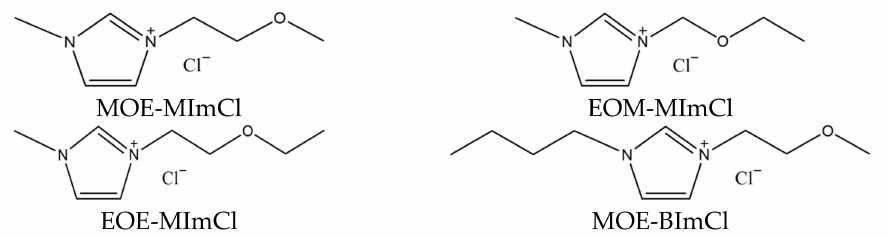
Figure 1. Structures of ether-functionalized ionic liquids